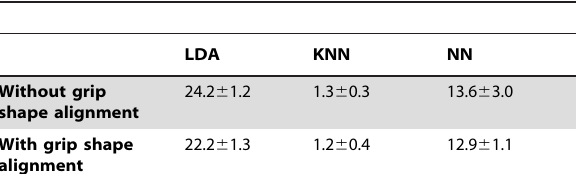
Table 3. Error rates in the classification of full grip shape